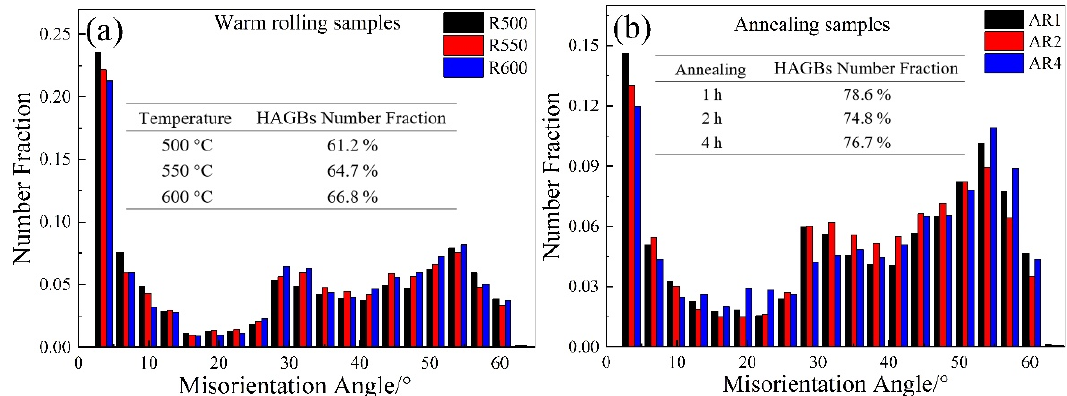
Figure 5. The grain boundary misorientation distribution: ( a ) warm rolling samples and ( b ) annealing samples.